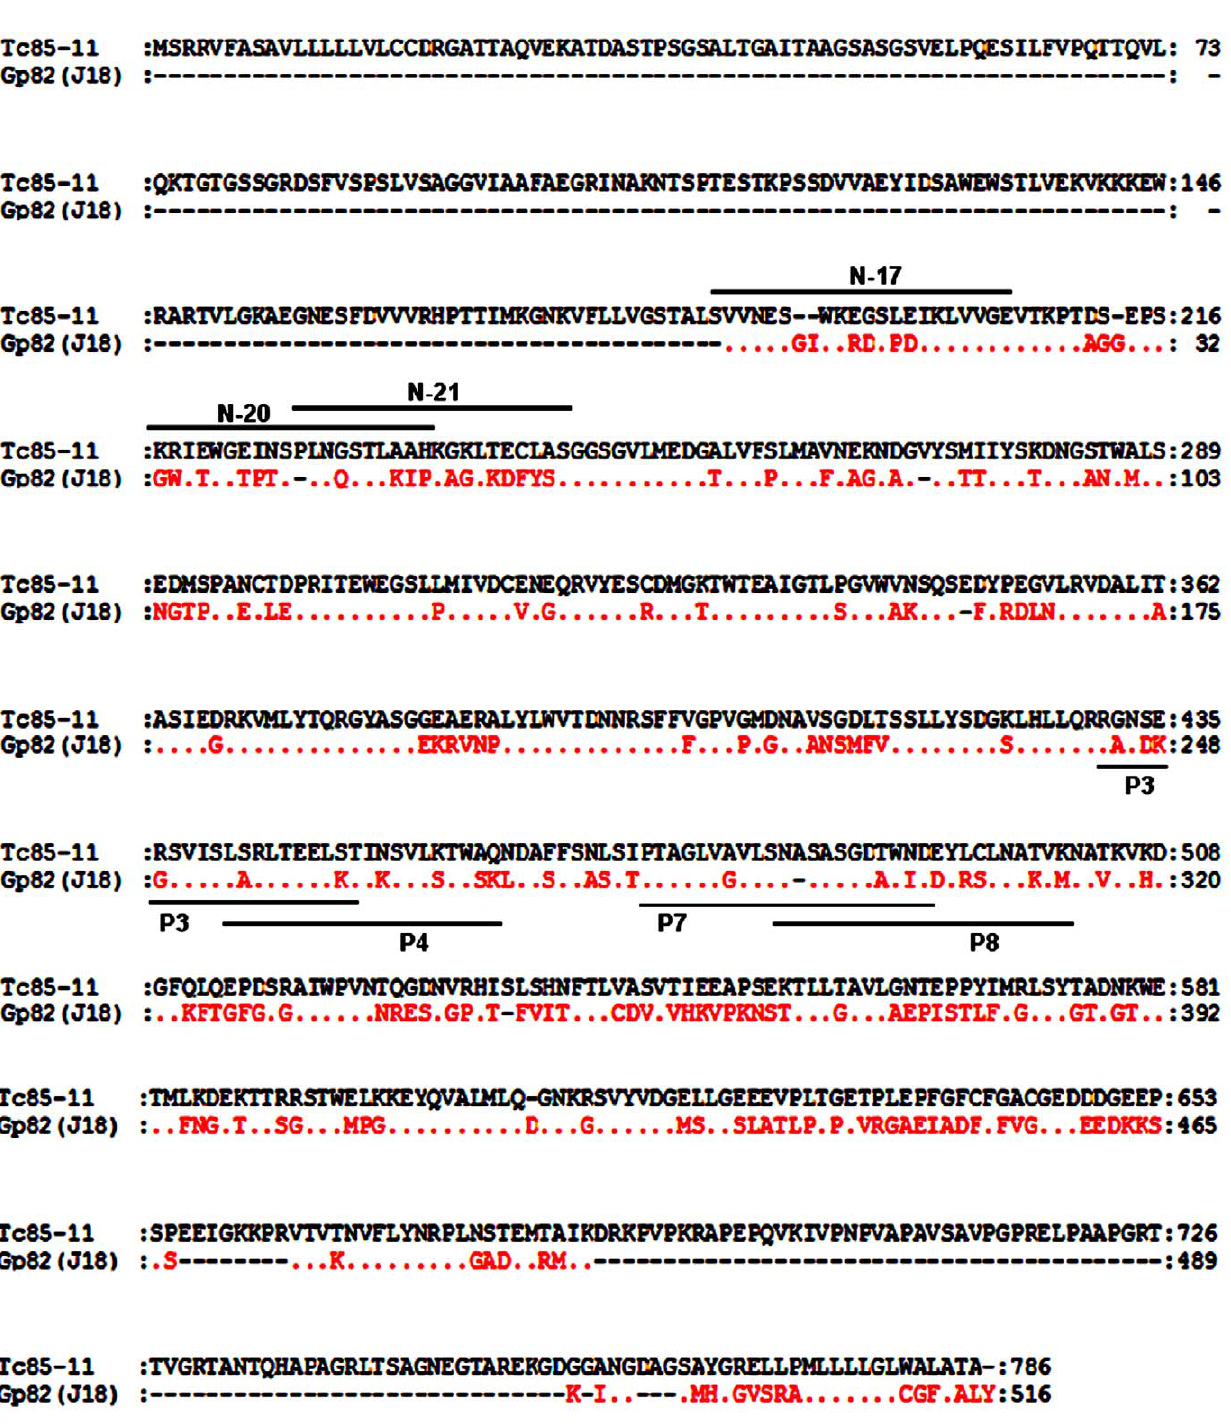
Figure 1. Sequences of T.cruzi surface proteins gp82 and Tc85-11. Shown are the aminoacid sequences deduced from cDNA clone J18, containing the full-length metacyclic stage gp82 (GenBank L14824), and from the cDNA insert containing Tc85-11 open reading frame (GenBank AF085686). In gp82, the sequences identified as P4 and P8 represent the host cell binding sites, P3 corresponds to the epitope for mAb 3F6, and P7 constitutes the main gastric mucin-binding site. In Tc85-11, the sequences corresponding to cell adhesion sites are identified as N-17, N-20 and N-21 and overlap with laminin-binding sites N17 and N-21 [34]. Points represent residues that are conserved in the two proteins, nonconserved amino acids are indicated, and dashes represent residues that are lacking.